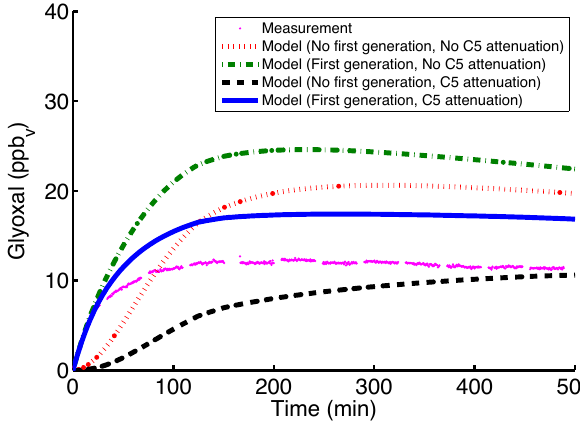
Fig. 5. Comparison of measured glyoxal concentration and MCM prediction for Exp.2. Attenuation of glyoxal production from C5 hydroxycarbonyls to 1/6 of MCM v.3.2 values brings the model into closer agreement with measurement during the latter part of the experiment. First-generation glyoxal yield is set to